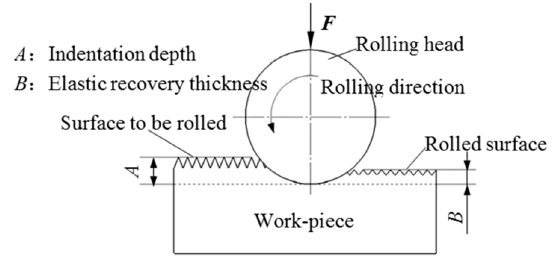
Figure 1. Schematic of rolling process.